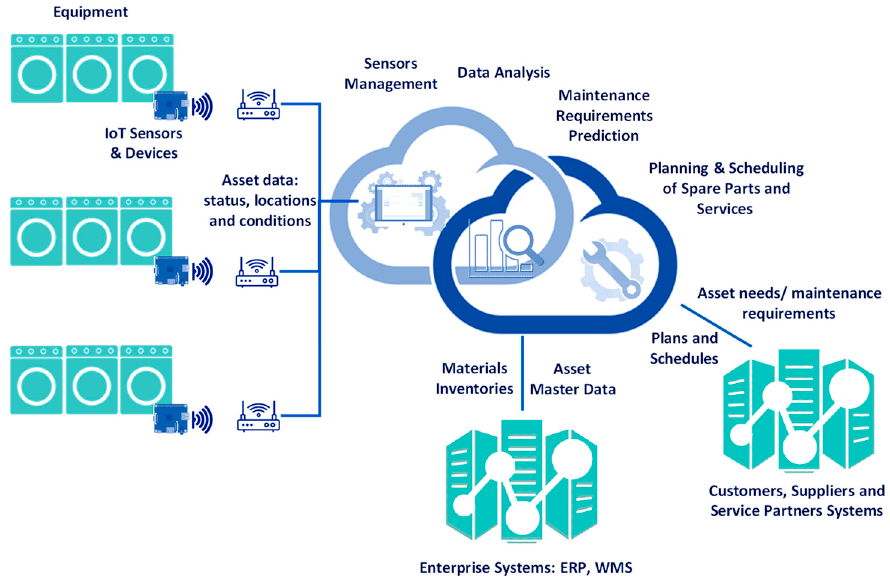
Figure 3. System’s Architectural Design.